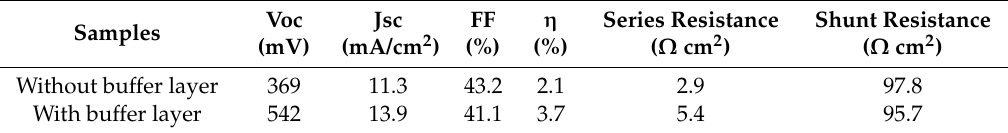
Figure 7. Dark and illuminated I-V curves of the heterostructures. Table 1. Extracted PV parameters from the I-V curves of the CdS/CdTe devices.